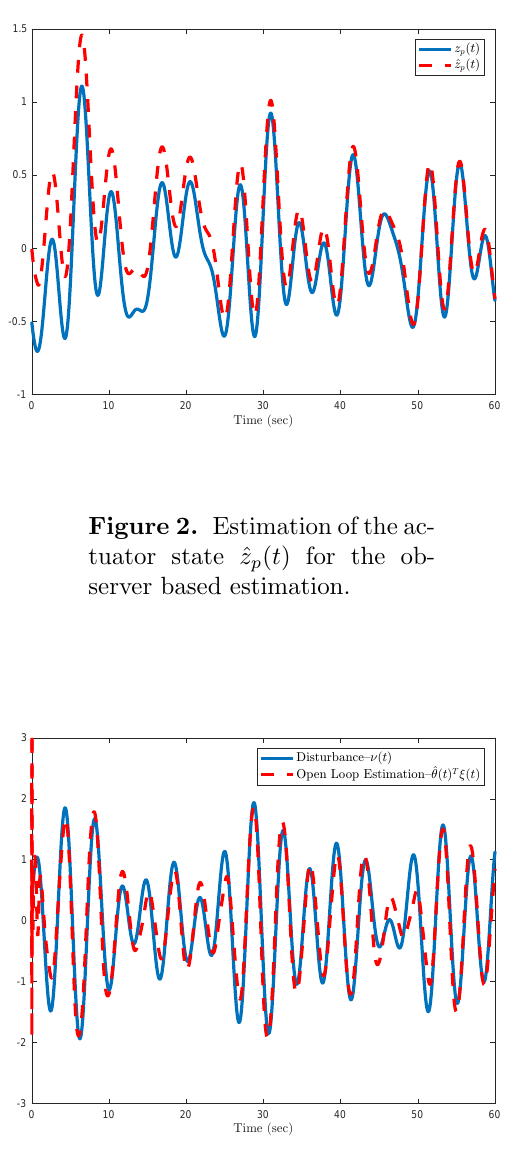
Figure 3. The actual distur- bance signal ν ( t ) and its esti- mate, ˆ θ T ( t ) ξ ( t ), for the observer based estimation.